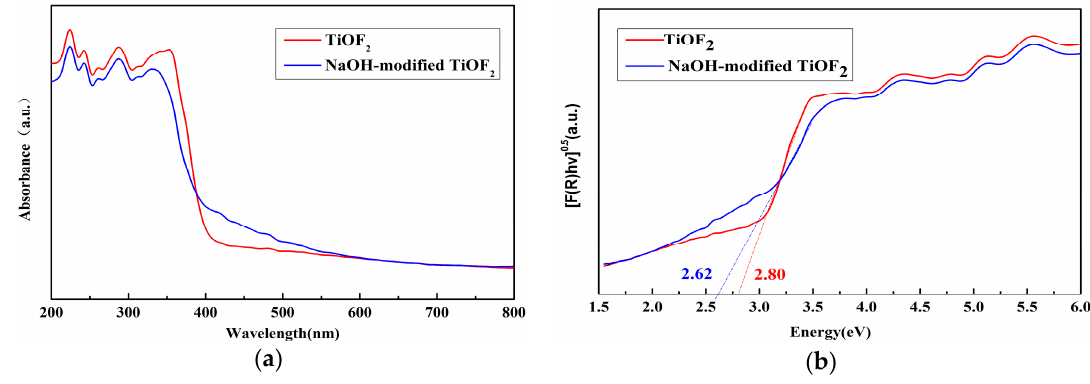
Figure 4. UV–vis DRS spectra ( a ) and band gap ( b ) of TiOF 2 and NaOH-modified TiOF 2 .